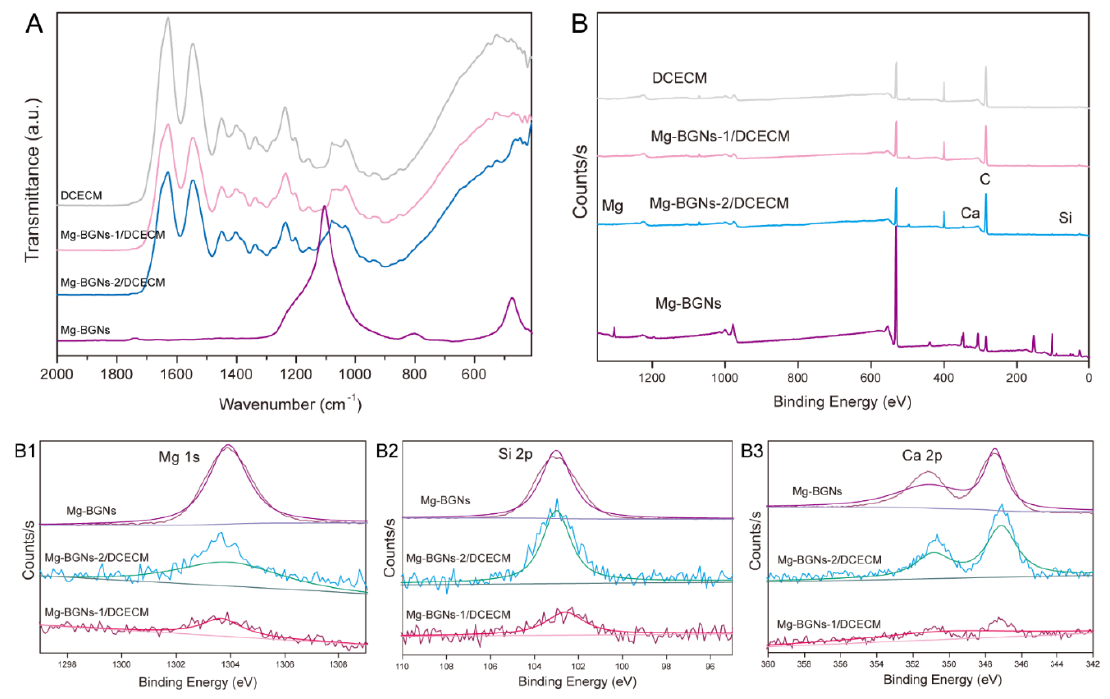
Figure 3. Physicochemical characterizations of Mg-BGNs/DCECM scaffolds: ( A ) Fourier transform infrared spectroscopy (FTIR) spectra of DCECM, Mg-BGNs-1/DCECM, Mg-BGNs-2/DCECM scaffolds, and Mg-BGNs; ( B ) The wide survey X-ray photoelectron spectroscopy (XPS) spectrum of DCECM, Mg-BGNs-1/DCECM, Mg-BGNs-2/DCECM, Mg-BGNs. The Mg 1s core-level spectra of Mg-BGNs-1/DCECM, Mg-BGNs-2/DCECM and Mg-BGNs is shown in ( B1 ), the Si 2p core-level spectra is shown in ( B2 ), and the Ca 2p core-level spectra is shown in ( B3 ).